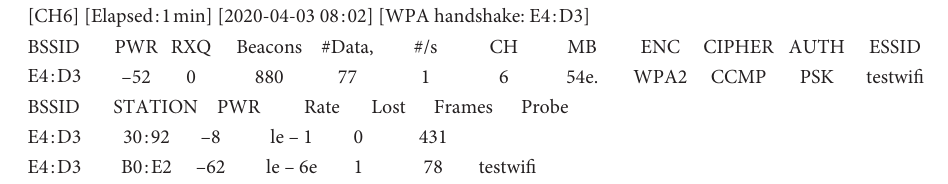
Figure 10: Airodump-ng capture